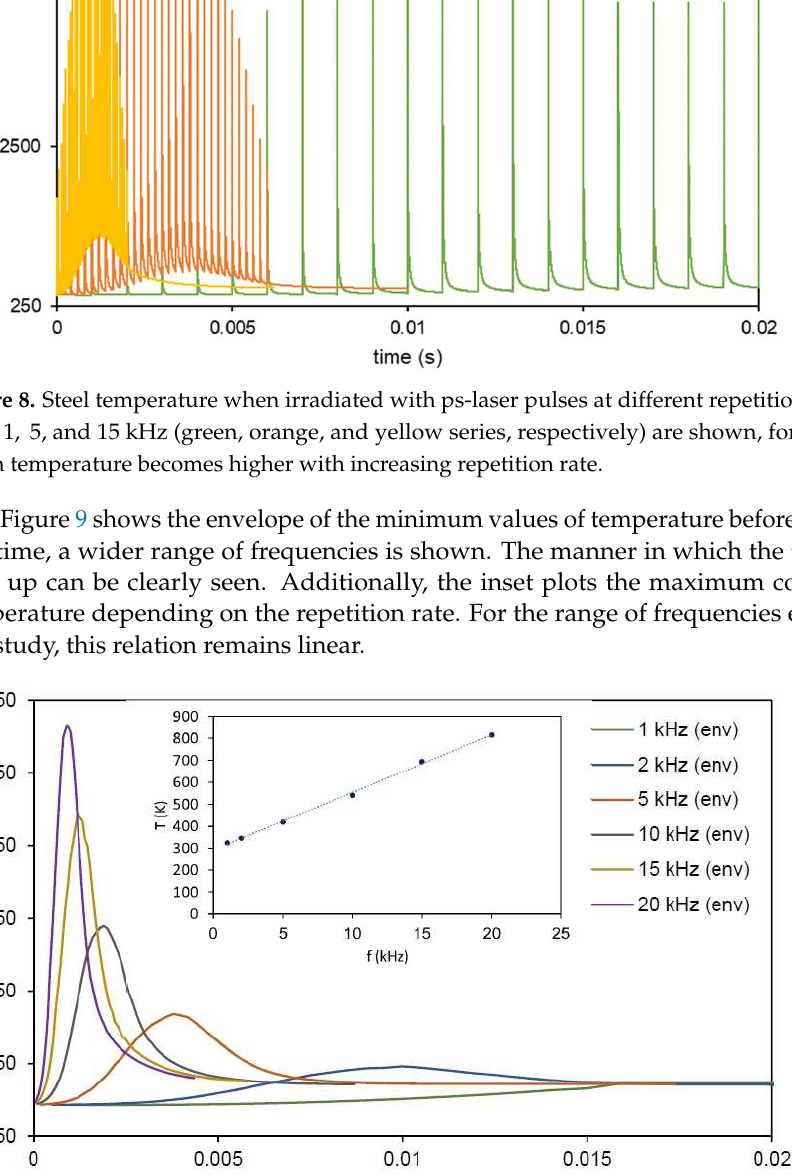
Figure 9. Envelope of the cool-down temperature depending on the repetition rate. Inset shows the linear behavior of the maximum cool-down temperature with frequency. Lines are visual guides.